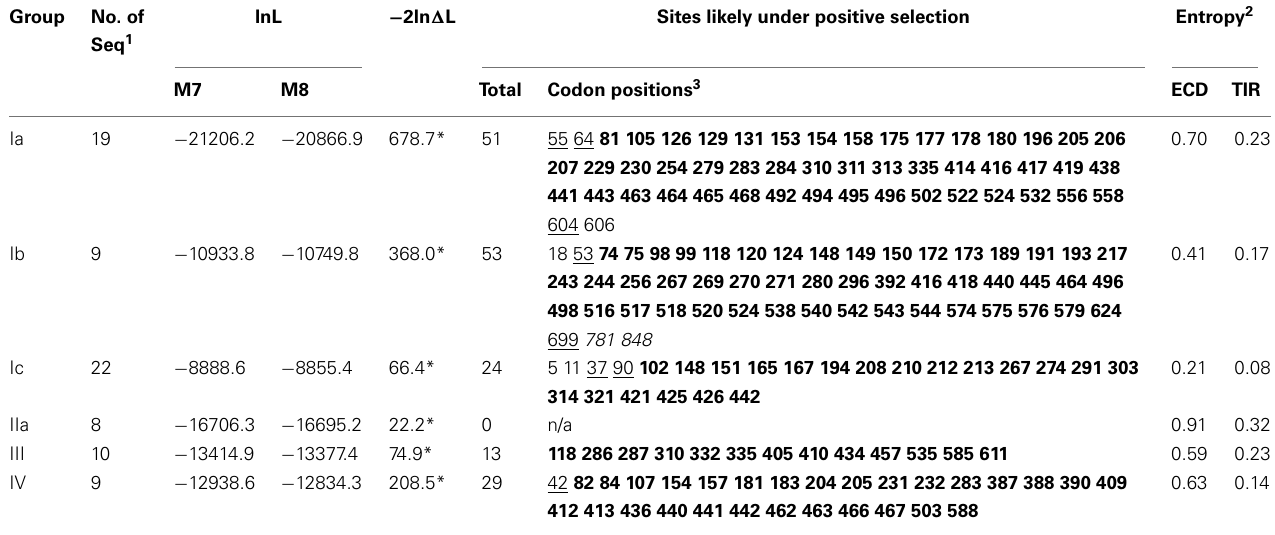
Table 2 | Diversity and evolution of theTLR